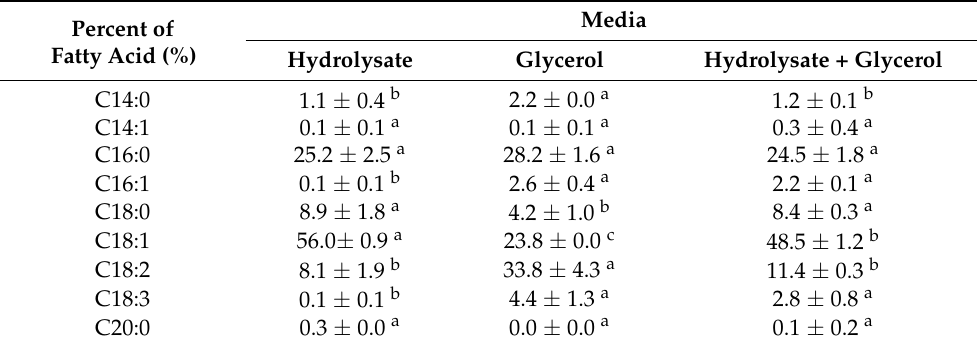
Table 3. Fatty acid composition of lipids when cultivated from R. glutinis 5159 in hydrolysate, glycerol, and hydrolysate mixed with glycerol at 30 ◦ C with orbital shaking at 200 rpm for 144 h. Percent